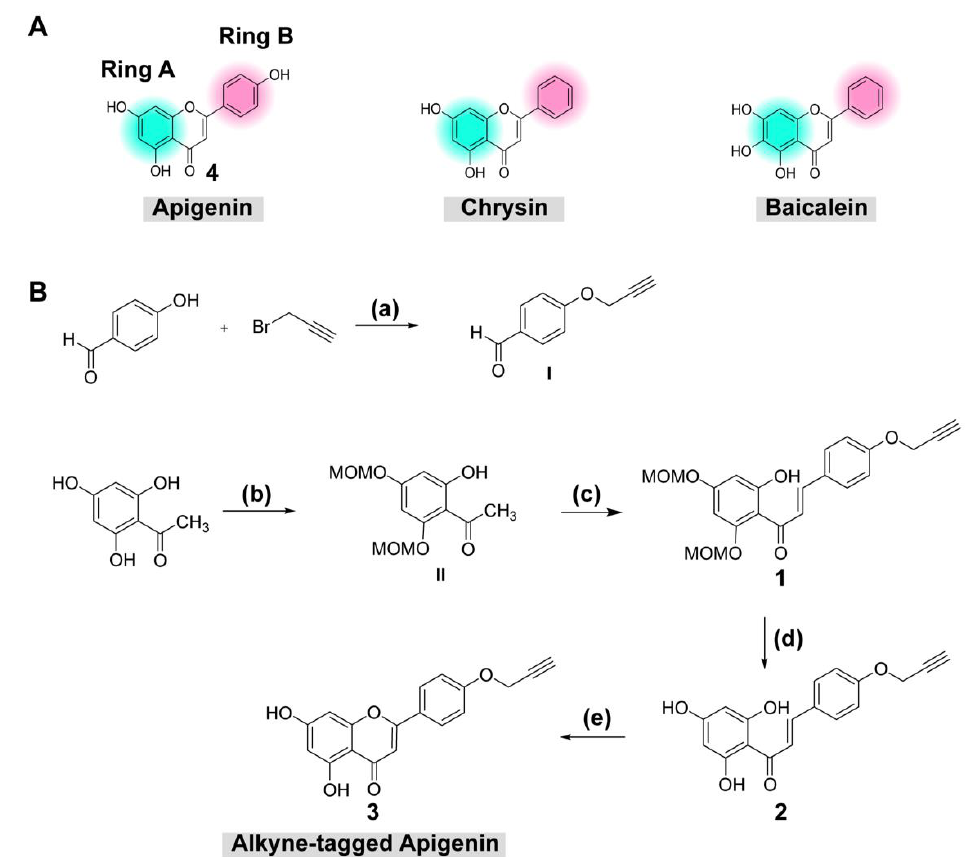
Figure 1. ( A ) Chemical structure of apigenin and ( B ) reagents and conditions for synthesis of alkyne- tagged apigenin: (a) K 2 CO 3 (3.0 equiv), acetone, 90 °C, 4 h (quantitative yield); (b) MOM-Cl (3.5 equiv), K 2 CO 3 (2.5 equiv), acetone, 90 °C, 4 h (20% yield), (c) I (2.0 equiv), aq 50% KOH, EtOH, rt, 24 h (57% yield); (d) 15% HCl/ i -PrOH, rt, 30 min (38% yield); (e) I 2 (cat.), DMSO, 90 °C, 2 h (20% yield).